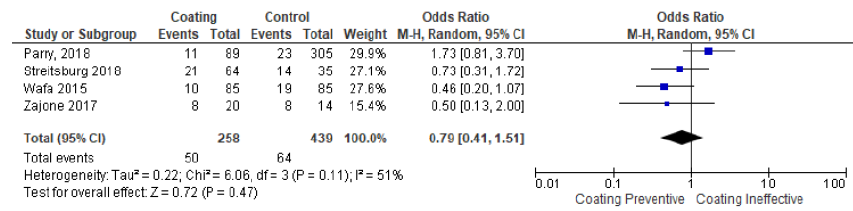
another antibiotic to reflect the antibiogram of the